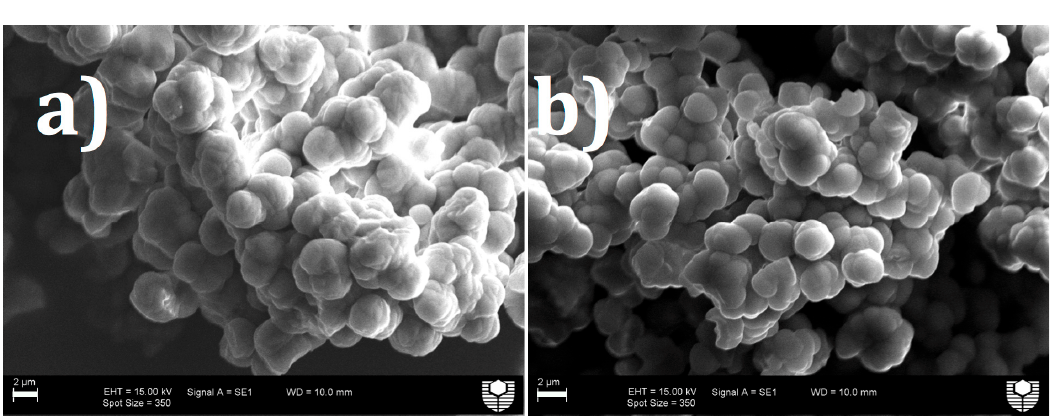
Figure 2. SEM images of jarosite particles formed for sample ( a ) jarosite H, and, ( b ) alunite (all scale bars 2 µm).